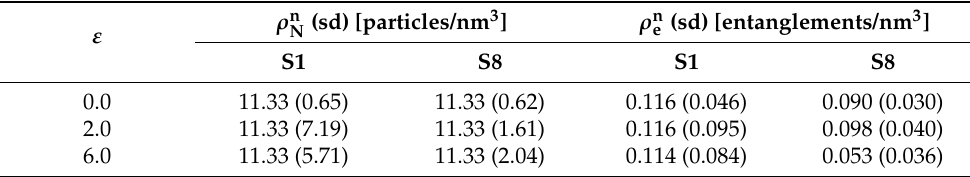
Table 4. Statistical values: arithmetic mean and standard deviation (sd) of ρ n different strains: 0.0 (initial state), 2.0 and 6.0.